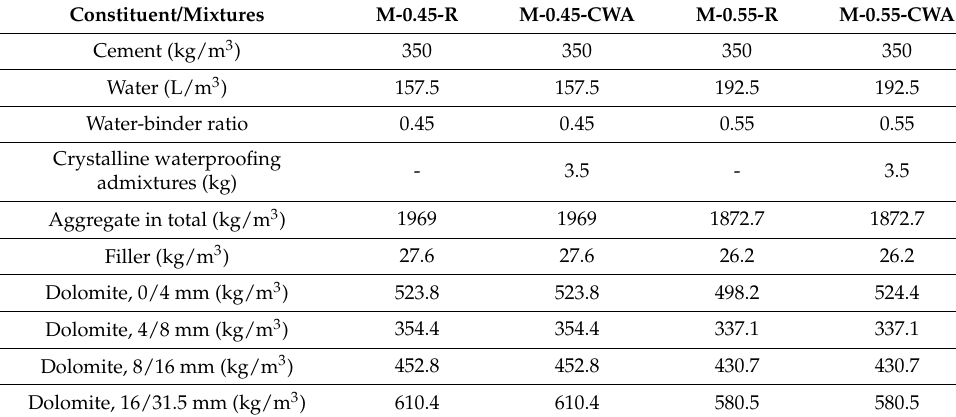
Table 2. Concrete mix